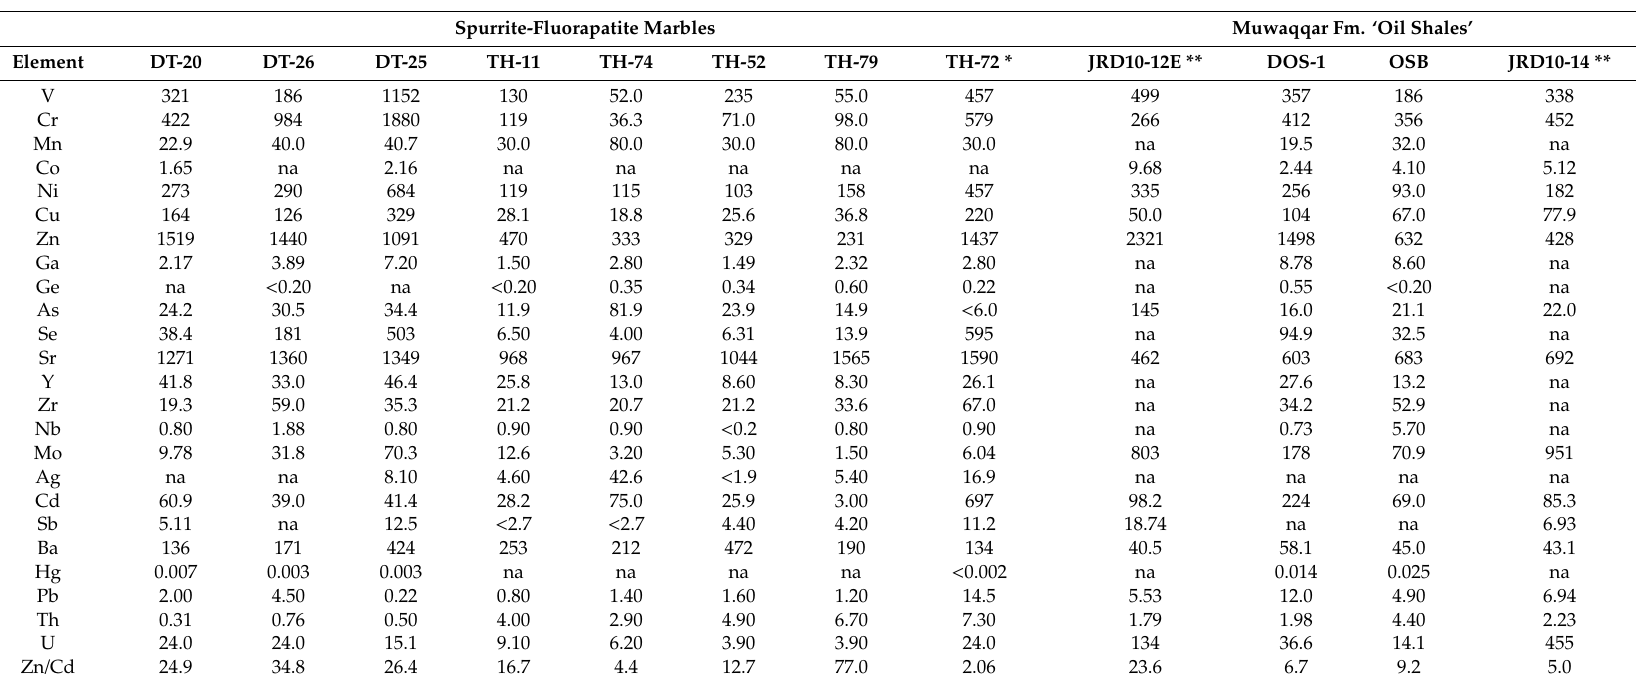
Table 1. Trace-element compositions of sphalerite-bearing CM marbles, Tulul al Hammam area (Daba-Siwaqa complex), and their sedimentary protoliths (‘oil shales’) of the Muwaqqar Chalk Marl Formation